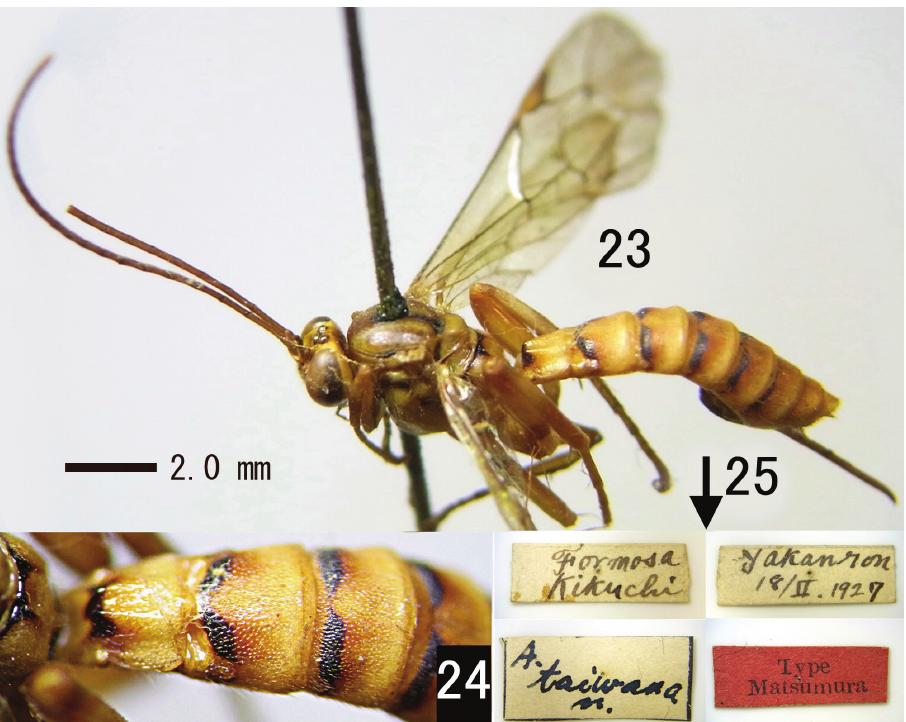
Figures 23–25. Holotype of A . taiwana Uchida. 23 habitus, dorso-lateral view 24 T1-T3, dorso-lateral view 25